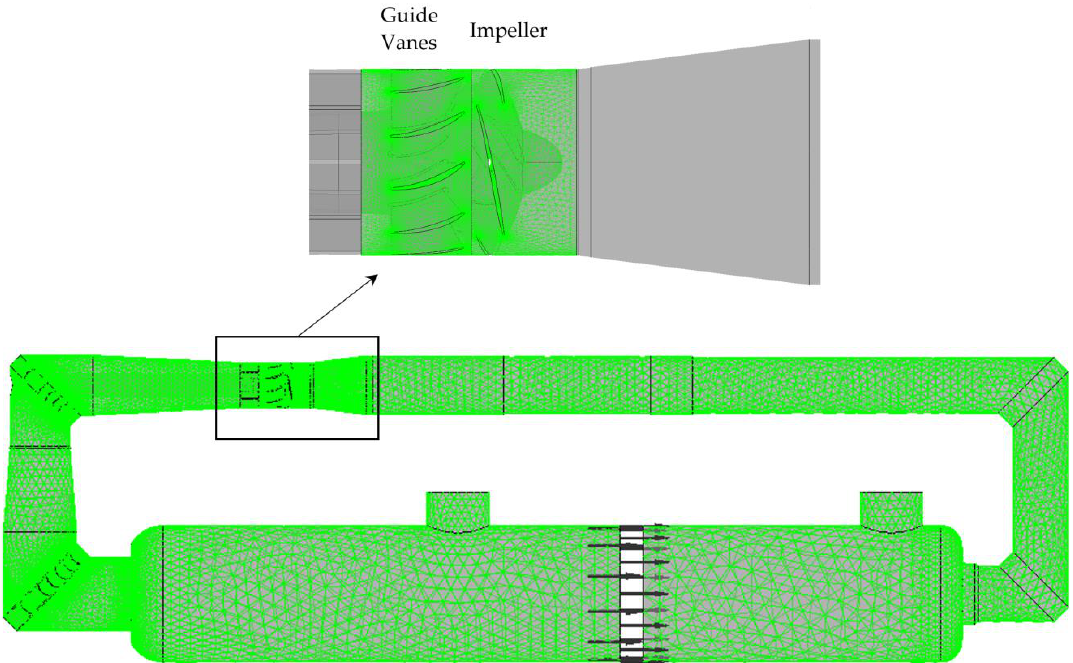
Figure 3. Calculation model of the experimental complex for testing axial-flow pumps.